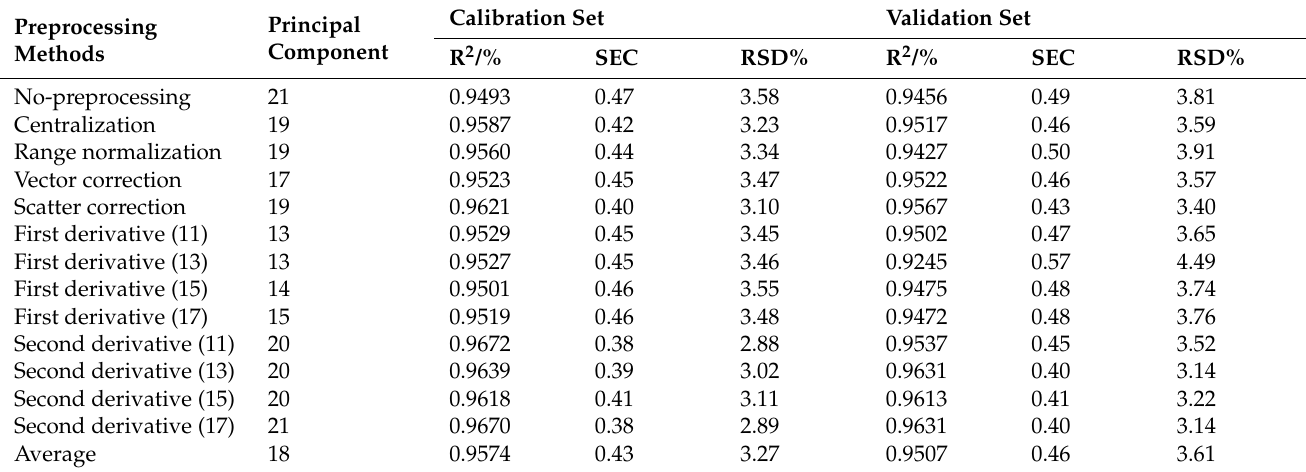
Table 6. The influence of different pretreatment and smoothing methods on NIRS prediction results